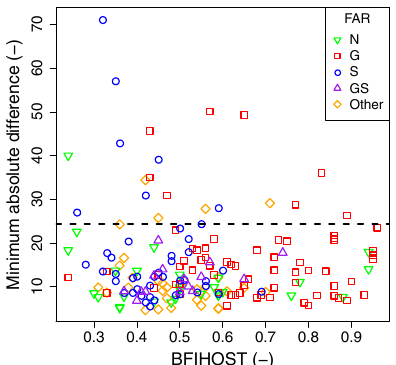
Figure 7. Minimum absolute difference ( A dif,min ) between the rel- ative cumulative sum of monthly streamflow ( C Q ) and precipita- ) drought occurrence versus the BFIHOST for records tion ( C P n with different FAR. Dashed line indicates selected subgroup of catchments with strongest deviating timing in drought occurrence ( A dif,min > 24 . 3; 95th quantile for catchments with FAR =